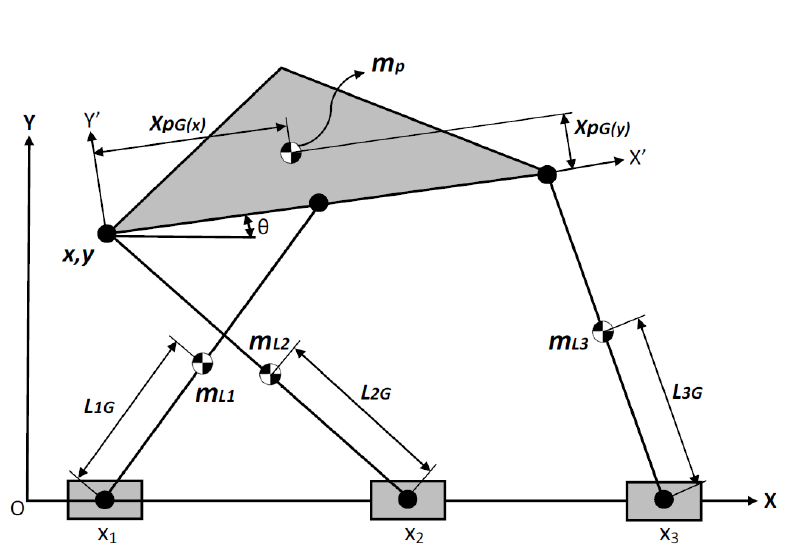
Figure 2. Centers of masses (COMs) of a 3PRR parallel kinematics mechanism.